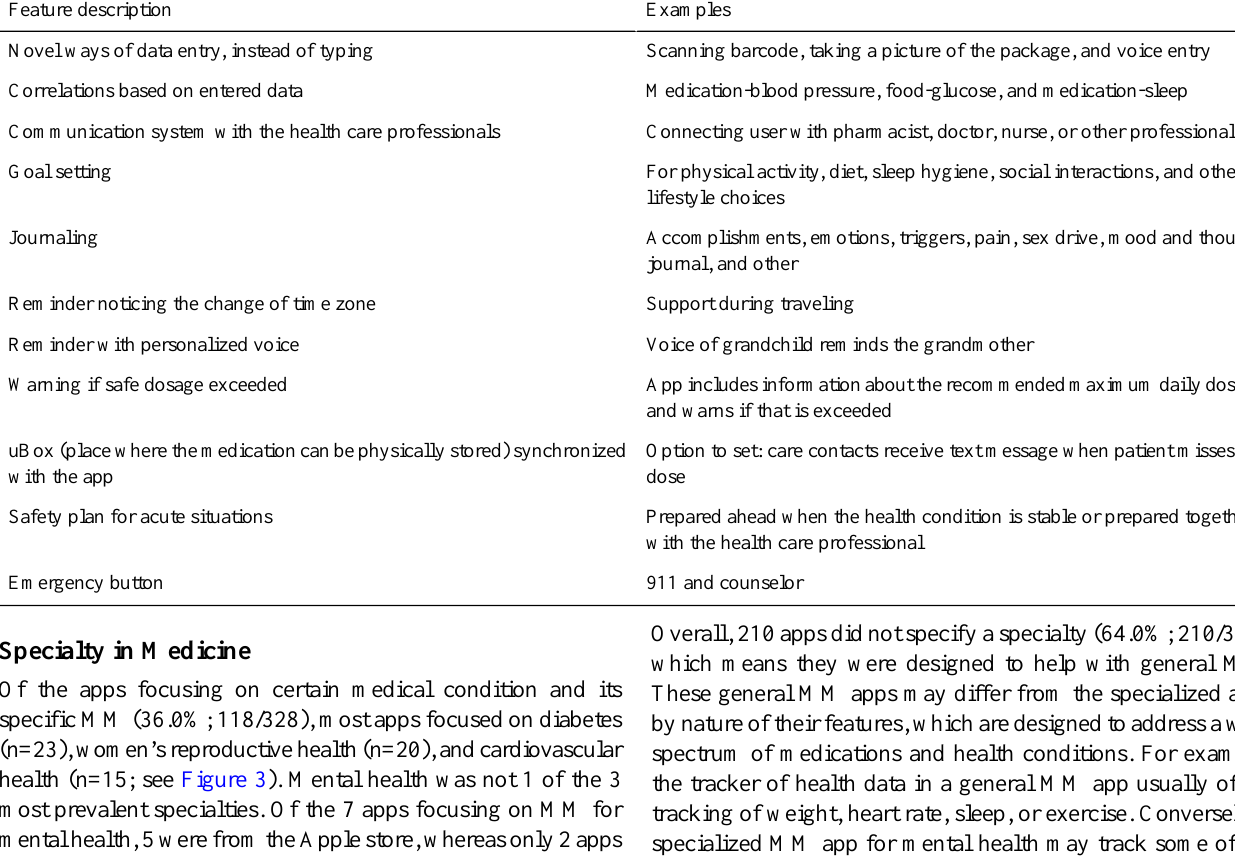
Table 4. Novel or innovative features of the